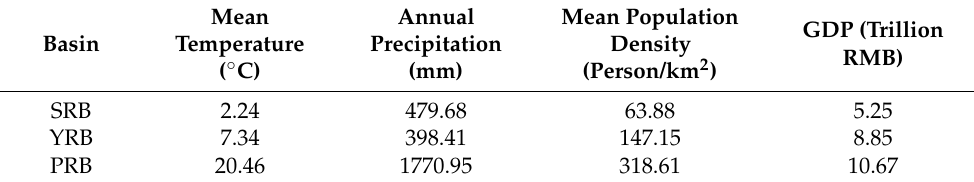
Table 1. Values of the four indicators in the three basins in 2015.